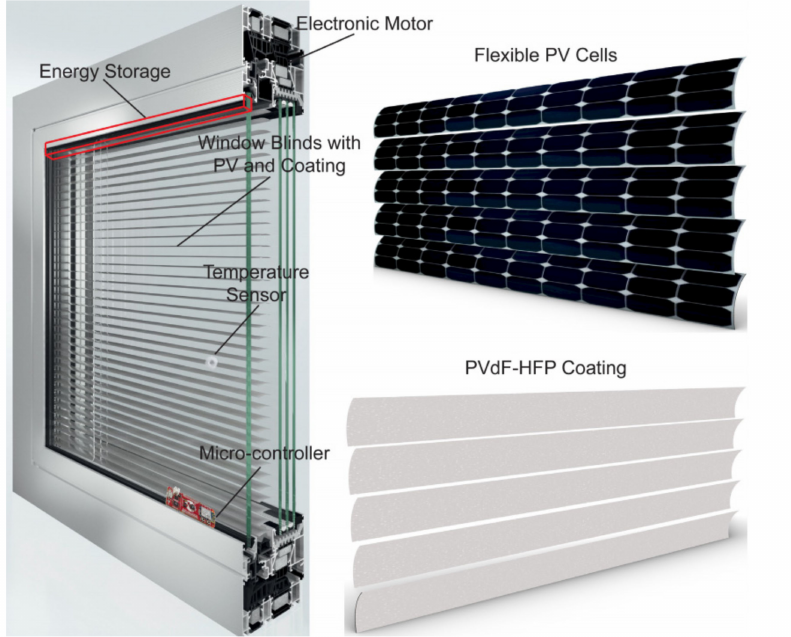
Figure 2. Smart window and louver blades [22]. Reprinted from Energy and Buildings, Design and experiment of a sun-powered smart building envelope with automatic control, Qiliang Lin, Yanchu Zhang, Arnaud Van Mieghem, Yi-Chung Chen, Nanfang Yu, Yuan Yang, Huiming Yin, 223 , 110173, Copyright 2020, with permission from